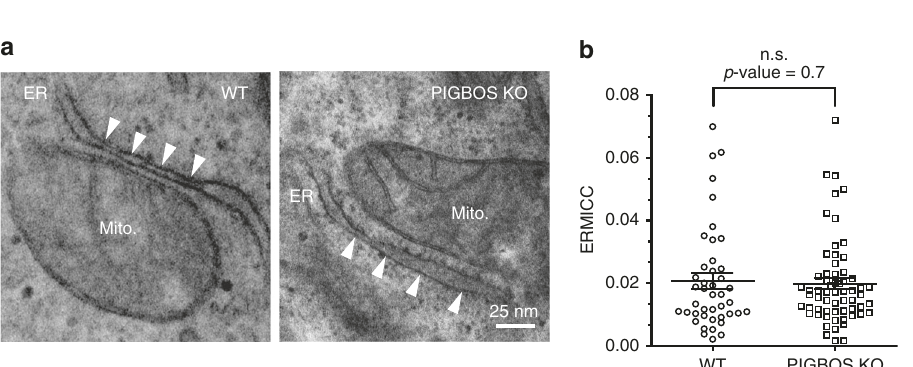
Fig. 4 Validation of PIGBOS-CLCC1 interaction via split GFP bimolecular complementation. a (Top) Transfection of COS-7 cells with PIGBOS-3 × GFP11 and CLCC1-GFP(1-10) resulted in a GFP signal, which could only occur if the two proteins are close enough to interact and reconstitute a functional GFP. Scale bar: 2 µ m. (Bottom) The region in the white box was enlarged, and a cross-sectional analysis of the normalized fl uorescence distribution of the Tom20 (MOM), Sec61b (ER), and GFP signals places the GFP signal between the ER and MOM. Scale bar: 0.5 µ m. b U2OS cells were co-transfected with CLCC1- GFP(1-10)-HA and PIGBOS-3 × GFP11-FLAG (or PIGBOS- Δ C-3 × GFP11-FLAG). Forty-eight hours later, cells were fi xed and stained with FLAG and HA antibodies overnight before imaging. Scale bar: 10 µ m. c Flow cytometry measurement of PIGBOS-CLCC1 interaction in HEK293T cells. HEK293T cells were co-transfected with CLCC1-GFP(1-10)-HA and PIGBOS-3 × GFP11-FLAG (or PIGBOS- Δ C-3 × GFP11-FLAG). GFP signals were assessed by fl ow cytometry 72 hours after transfection. d Quanti fi cation of mean GFP intensity in ( c ). Error bars, s.d., *** p < 0.001 (two tailed unpaired t -test), n = 3 independent experiments. e Flow cytometry measurement of reconstituted PIGBOS-CLCC1 split GFP intensity in HEK293T cells expressing a known ER-mitochondrial tether, VAPB/PTPIP51. Error bars, s.d., ** p < 0.01 (two tailed unpaired t -test), n = 5 independent experiments. Source data for Fig. 4a, d and e are provided